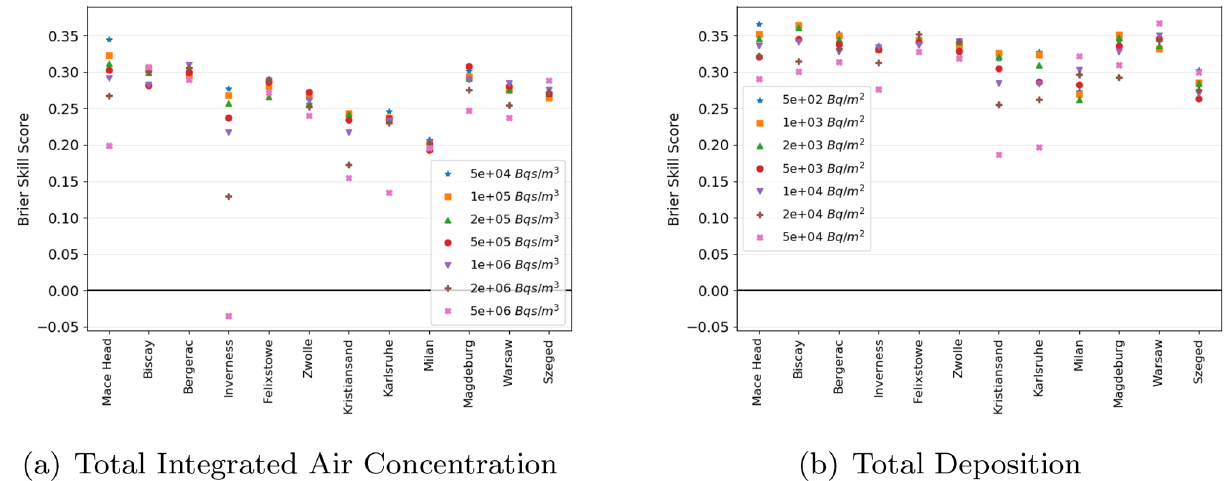
Figure 4. Average Brier skill score for (a) total integrated air activity of Cs-137 and (b) total accumulated deposits of Cs-137 for each of the 12 release locations and each of the six